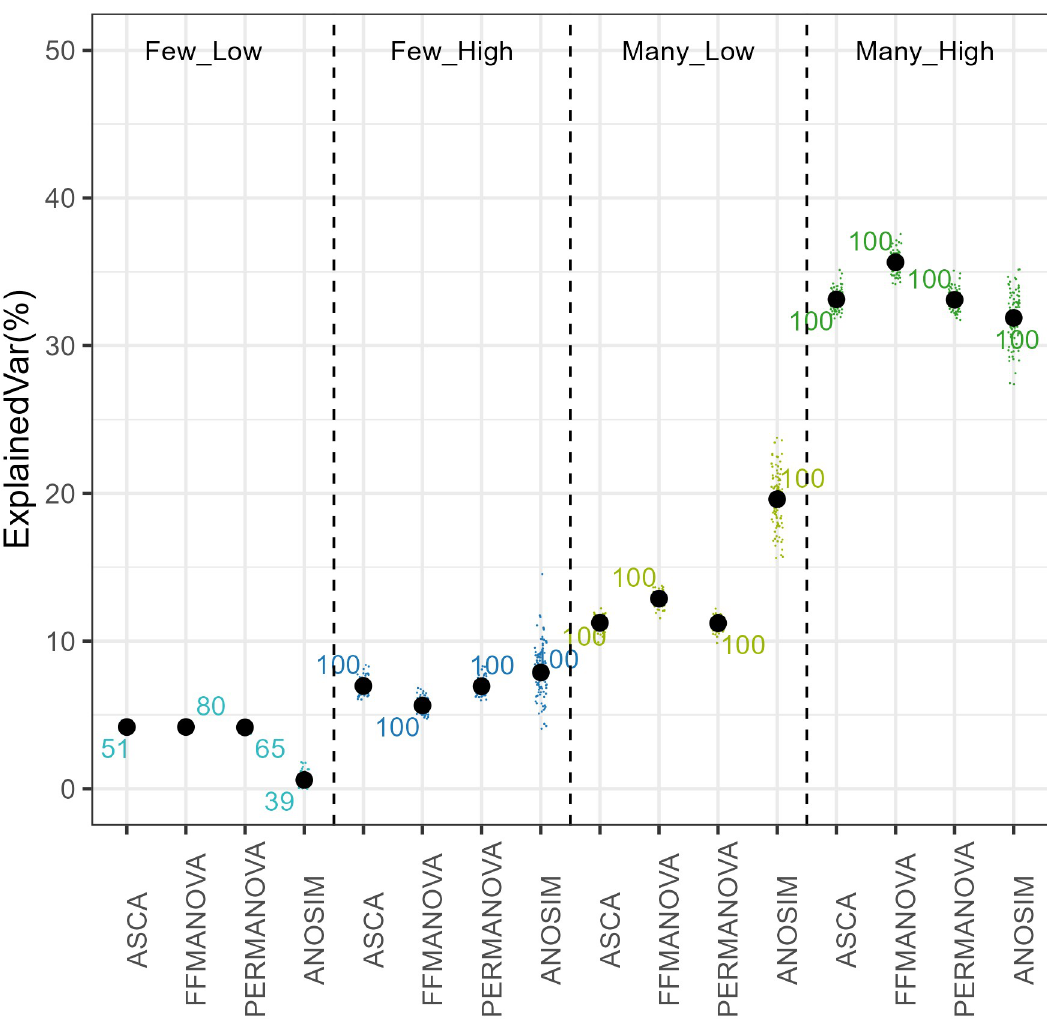
Fig 2. Explained variance for simulated data and the relative number of simulations where the simulated effect was detected. Numbers indicate the percentage of simulated data sets where p-value was